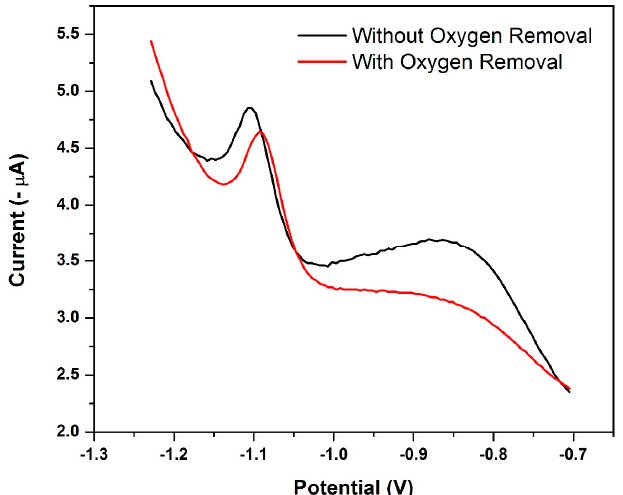
Figure 15. Square-Wave Voltammogram of 4 µg L − 1 Ni 2+ at a NGr-DMG-GCE before deoxygenation (black) and after deoxygenation (red). Supporting electrolyte (0.1 M NH 3 /NH 4 Cl Buffer (pH 9.3)), deposition potential ( − 0.7 V), deposition time (120 s), frequency (20 Hz), amplitude (0.02 V) and voltage step (0.005 V).